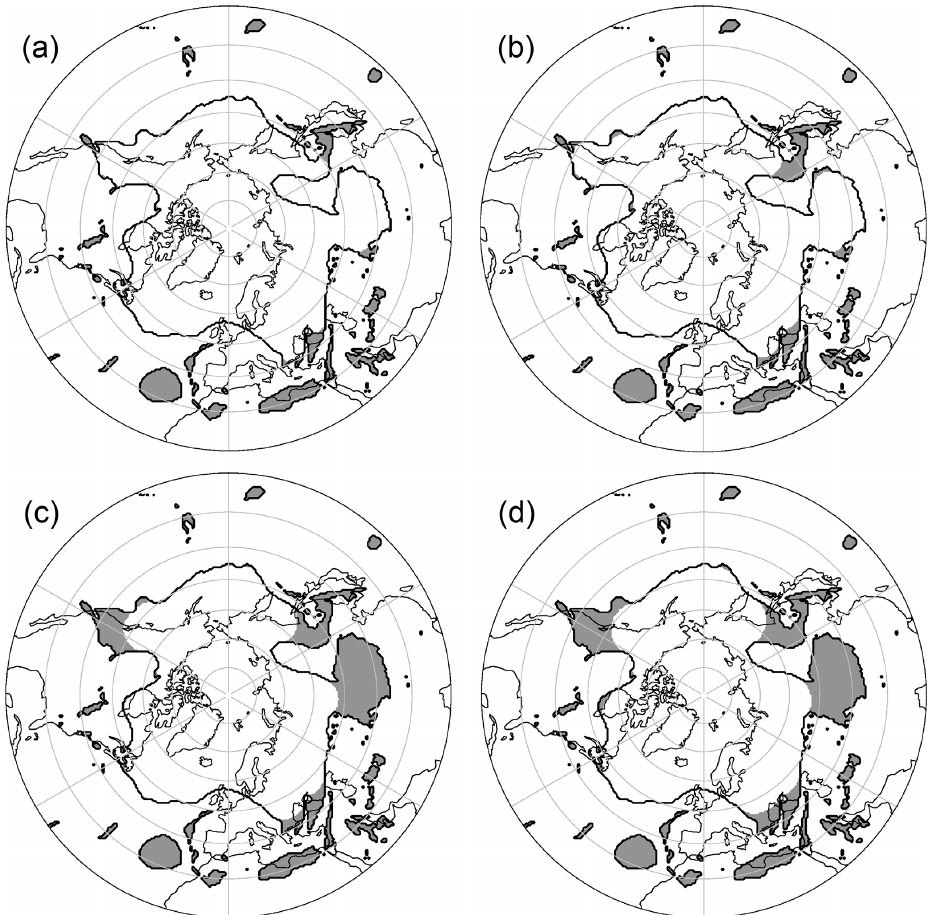
Figure 5. Sensitivity of the identification process to the width threshold w . Here, w equals (a) 500km, (b) 1000km, (c) 1500km, and (d) 2000km, using the example of the 330K isentrope from the ERA5 reanalysis on 14 July 2015, 00:00UTC. Results are not filtered to highlight the effect of the parameter. Our default configuration is (c)